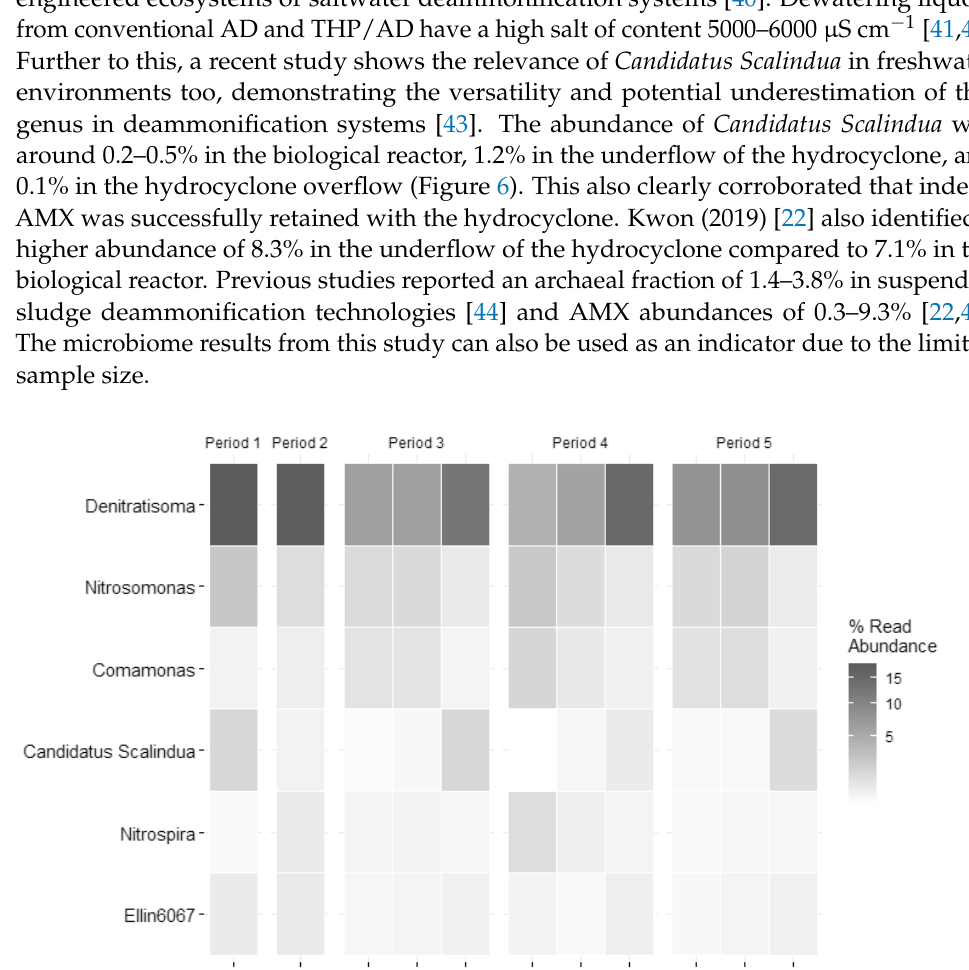
Figure 6. The relative abundance of main genus types for AMX ( Candidatus Scalindua ), denitrification ( Denitratisoma ), partial nitritation ( Nitrosomas ), and nitratation ( Nitrospira ) for hydrocyclone overflow underflow as well as a reactor for Period 1 to Period 5.